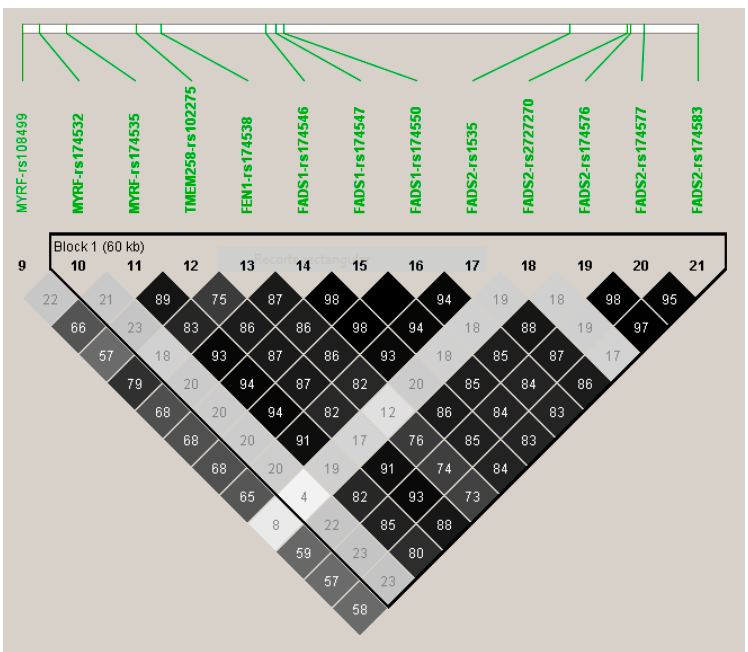
Figure 3. Linkage disequilibrium (r 2 ) among the top-ranked SNPs ( p < 5 × 10 − 8 , in the model adjusted for sex, age, and diabetes) for the genome-wide association study on serum omega-3 fatty acid.